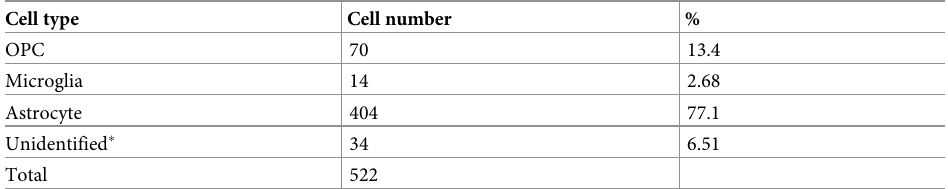
Table 1. The cell types and the number of cells